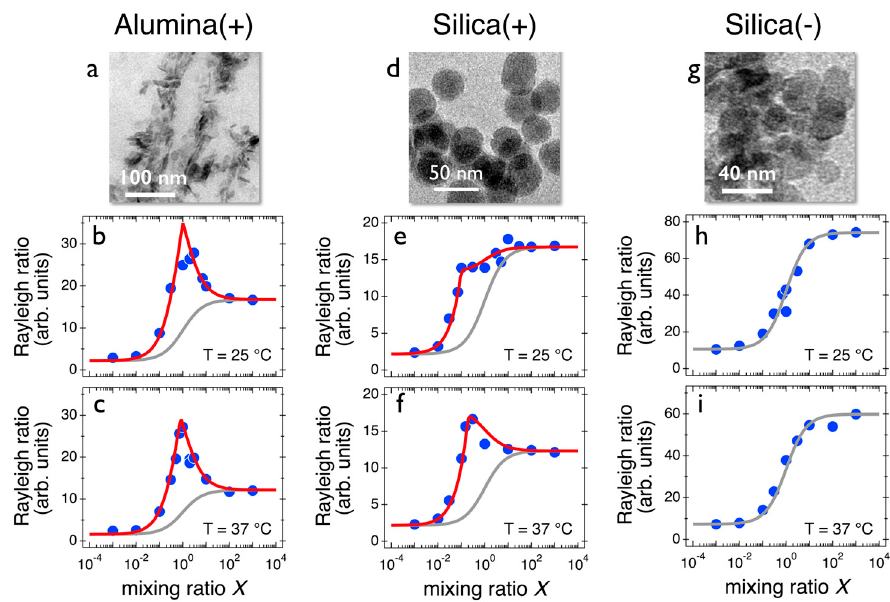
Figure 4. ( a , d , e ) Transmission electron microscopy images of alumina and silica (positive and negative) particles used in this study. The particles are dubbed Alumina (+), Silica (+), and Silica ( − ), respectively. ( b , c ) Rayleigh ratio of alumina-vesicle dispersions as a function of the mixing ratio at T = 25 ◦ C and T = 37 ◦ C, respectively. The continuous lines in red are from Equation (6), indicating the formation of mixed aggregates, and those in grey from Equation (3). ( e , f ) Same as in Figure 4b,c for Silica (+) particles. ( h , i ) Rayleigh ratio of negatively charged silica-vesicle dispersions as a function of the mixing ratio at T = 25 ◦ C and T = 37 ◦ C, respectively. The continuous lines in grey are from Equation (3), indicating no interaction.